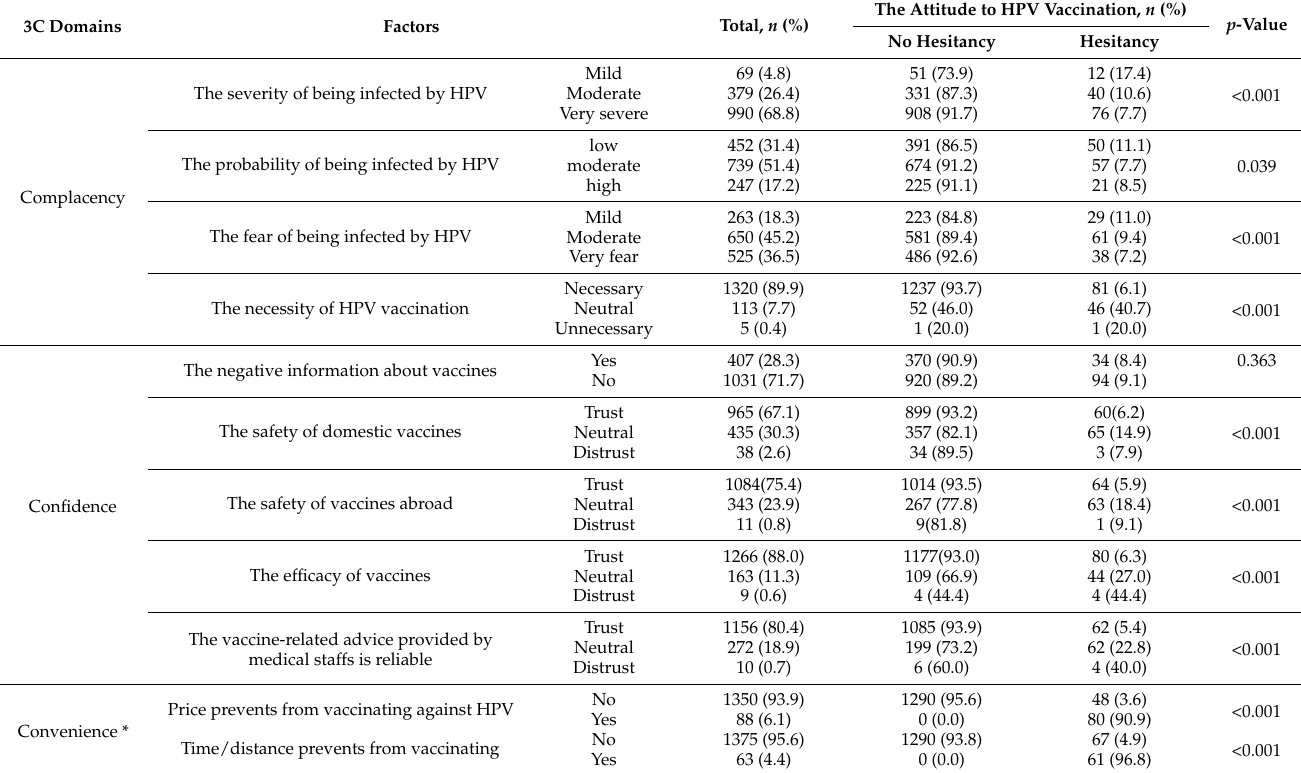
Table 3. Chi-square results of 3Cs factors by hesitancy status.